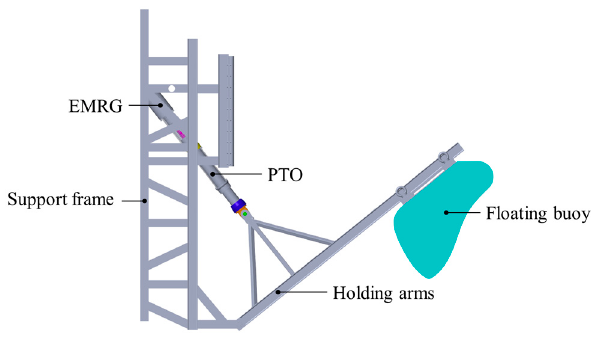
Figure 1. Onshore WEC structure designed by the UMBRA GROUP.